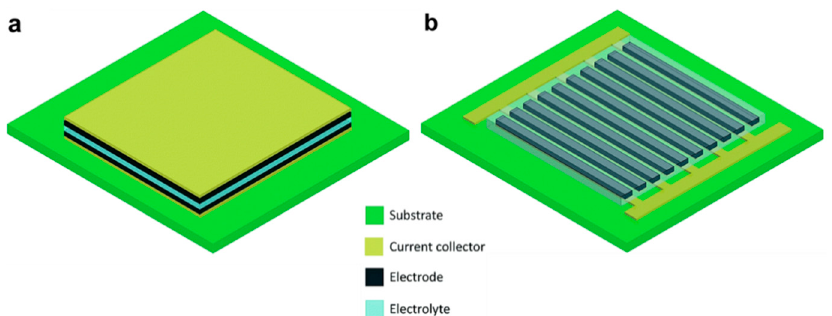
Figure 2. Schematics illustration of ( a ) sandwich and ( b ) planar configurations of micro- supercapacitors. Adapted with permission from Reference [12]. Copyright © 2014 The Royal Society of